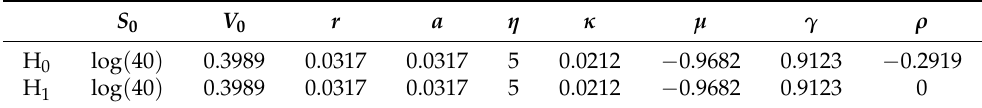
Table 1. The parameter values used in the simulation.